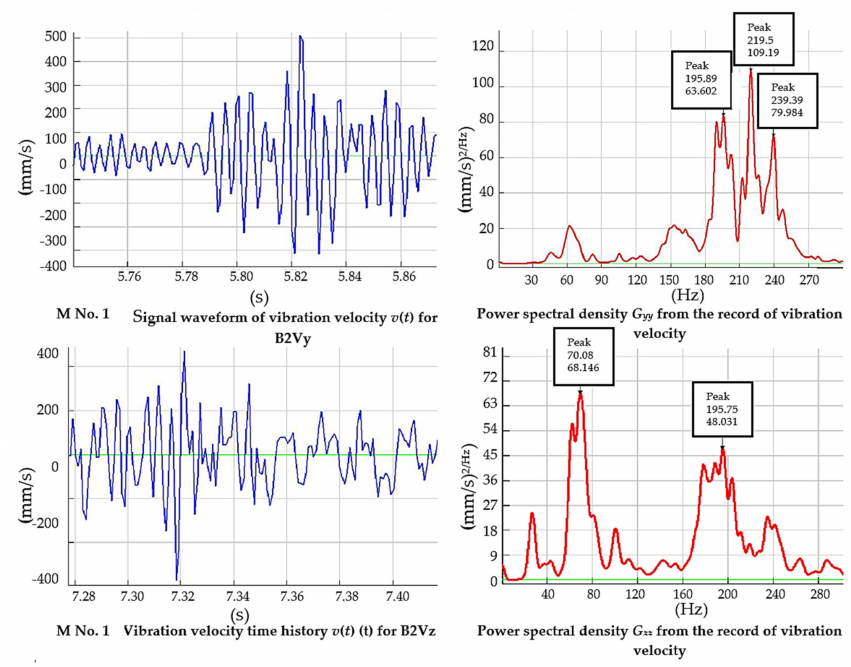
Figure 18. Vibration velocity time history v ( t ) and power spectral density Gii from vibration velocity record for measurements with achieved extreme values of vibration velocity